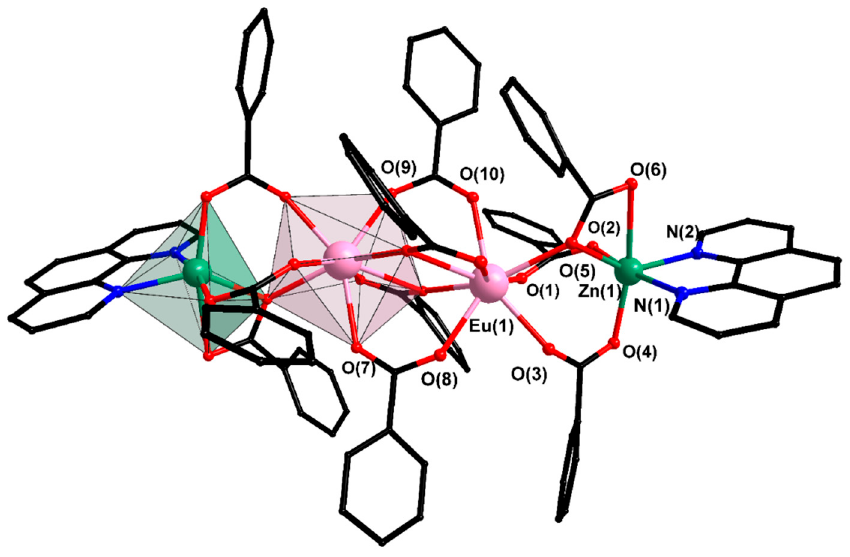
Figure 3. Structure of complex VI. Hydrogen and fluorine atoms are omitted.